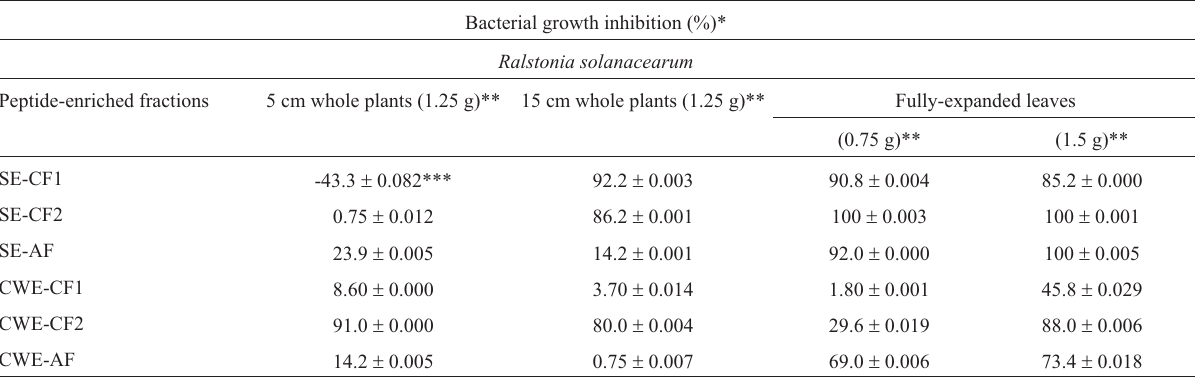
Table 1 - Antimicrobial activity of cationic (CF1, CF2) and anionic (AF) fractions obtained from soluble (SE) or cell-wall (CWE) extracts of young plants or fully-expanded leaves of eggplant (Almeida et al. , 2007, with authorization from the authors). Bacterial growth inhibition